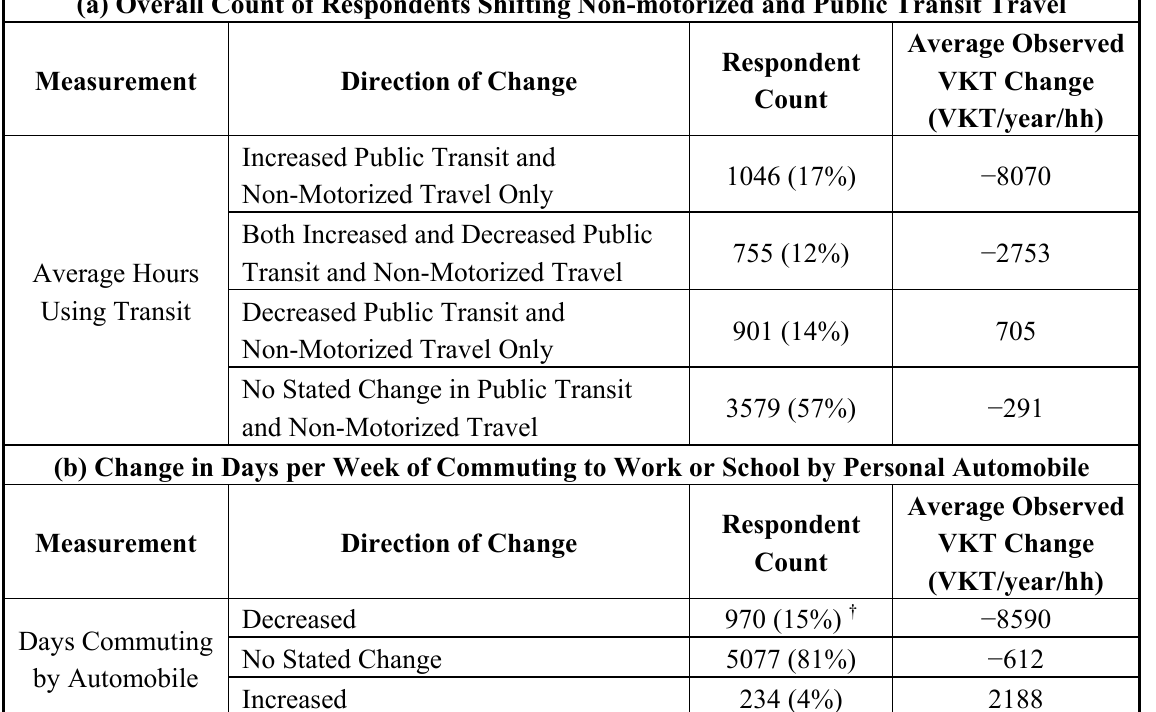
Table 5. Change in Non-Motorized/Public Transit Travel and Auto